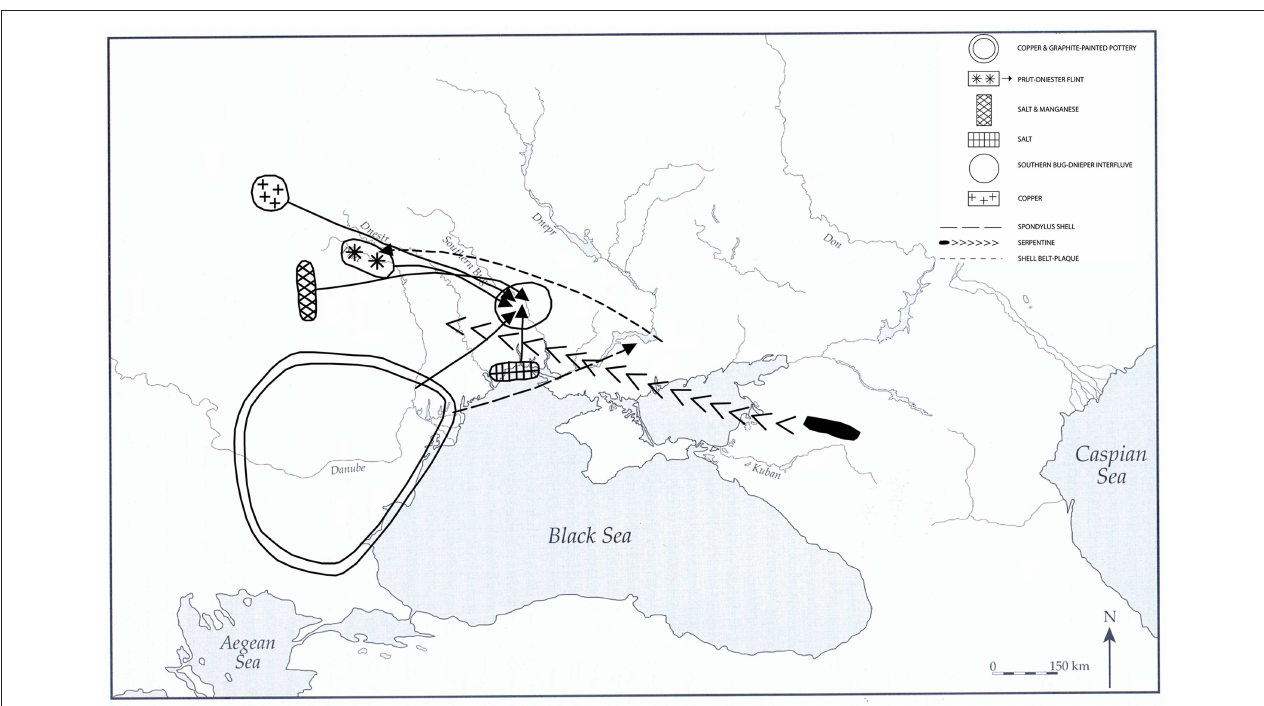
FIGURE 7 | Map of exotic resources, Cucuteni-Trypillia group. Key—symbols upper left denote the sources of the raw materials, with schematic routes shown from sources to settlement finds (L.